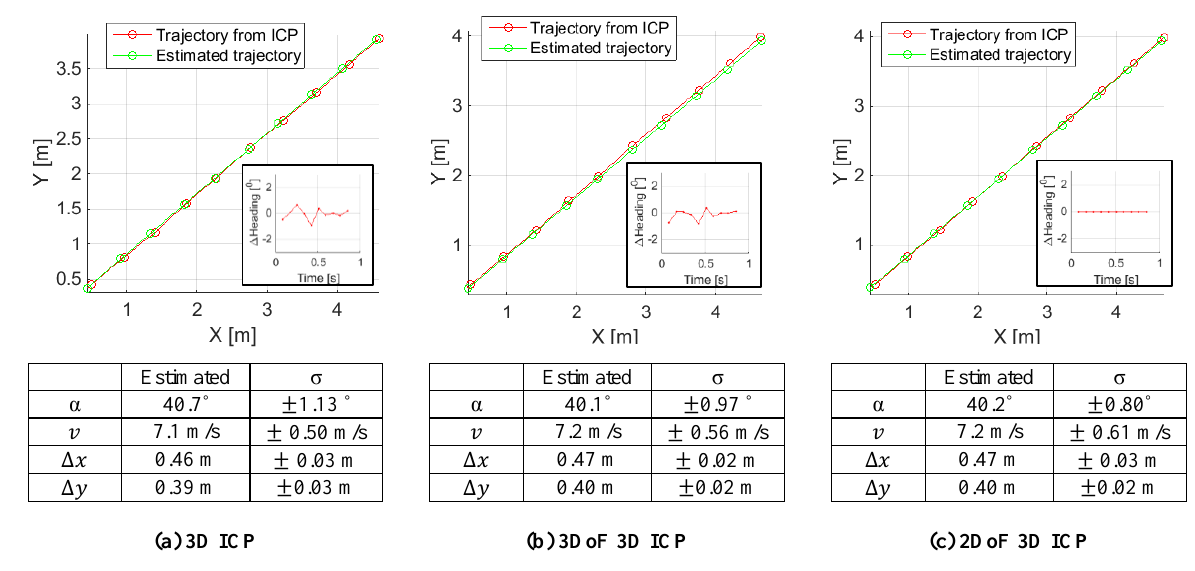
Figure 8. Estimated parameters